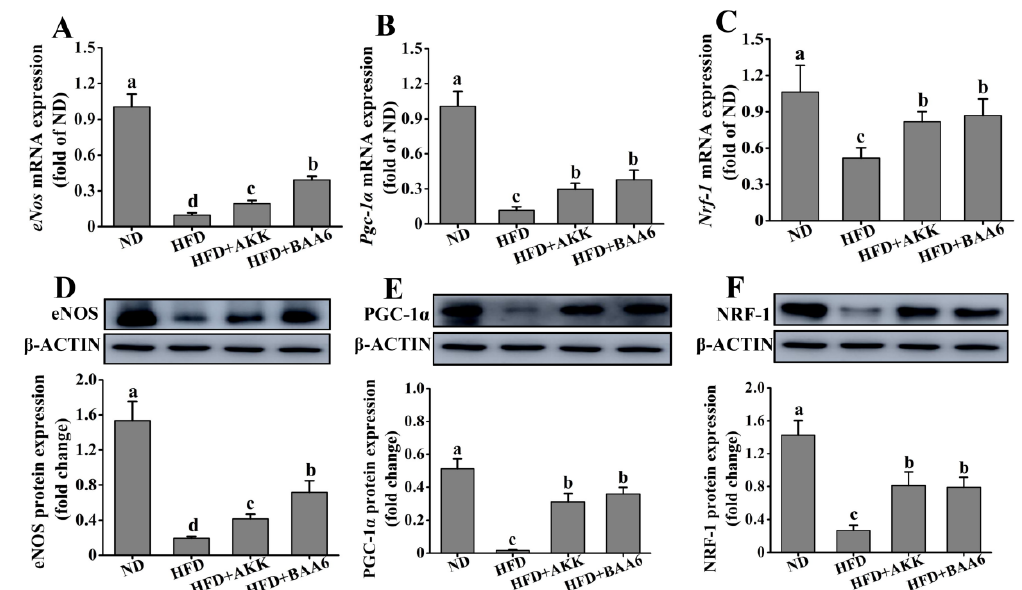
Figure 5. E ff ects of oral administration of BAA6 or AKK on endothelial nitric oxide synthase (eNOS) expression and mitochondrial biogenesis of epididymal adipose tissues in HFD-fed mice. ( A ) mRNA expression levels of endothelial nitric oxide synthase ( eNos ), ( B ) peroxisome proliferator-activated receptor γ coactivator 1 α ( Pgc-1 α ), and ( C ) nuclear respiratory factor-1 ( Nrf-1 ) and protein expression levels of ( D ) eNOS, (E) PGC-1 α , and ( F ) NRF-1 following daily treatment with 10 9 CFU / kg BAA6 or AKK. Values are expressed as means ± SD ( n = 6). Bars with di ff erent lowercase letters denote significant di ff erences among groups ( p < 0.05).